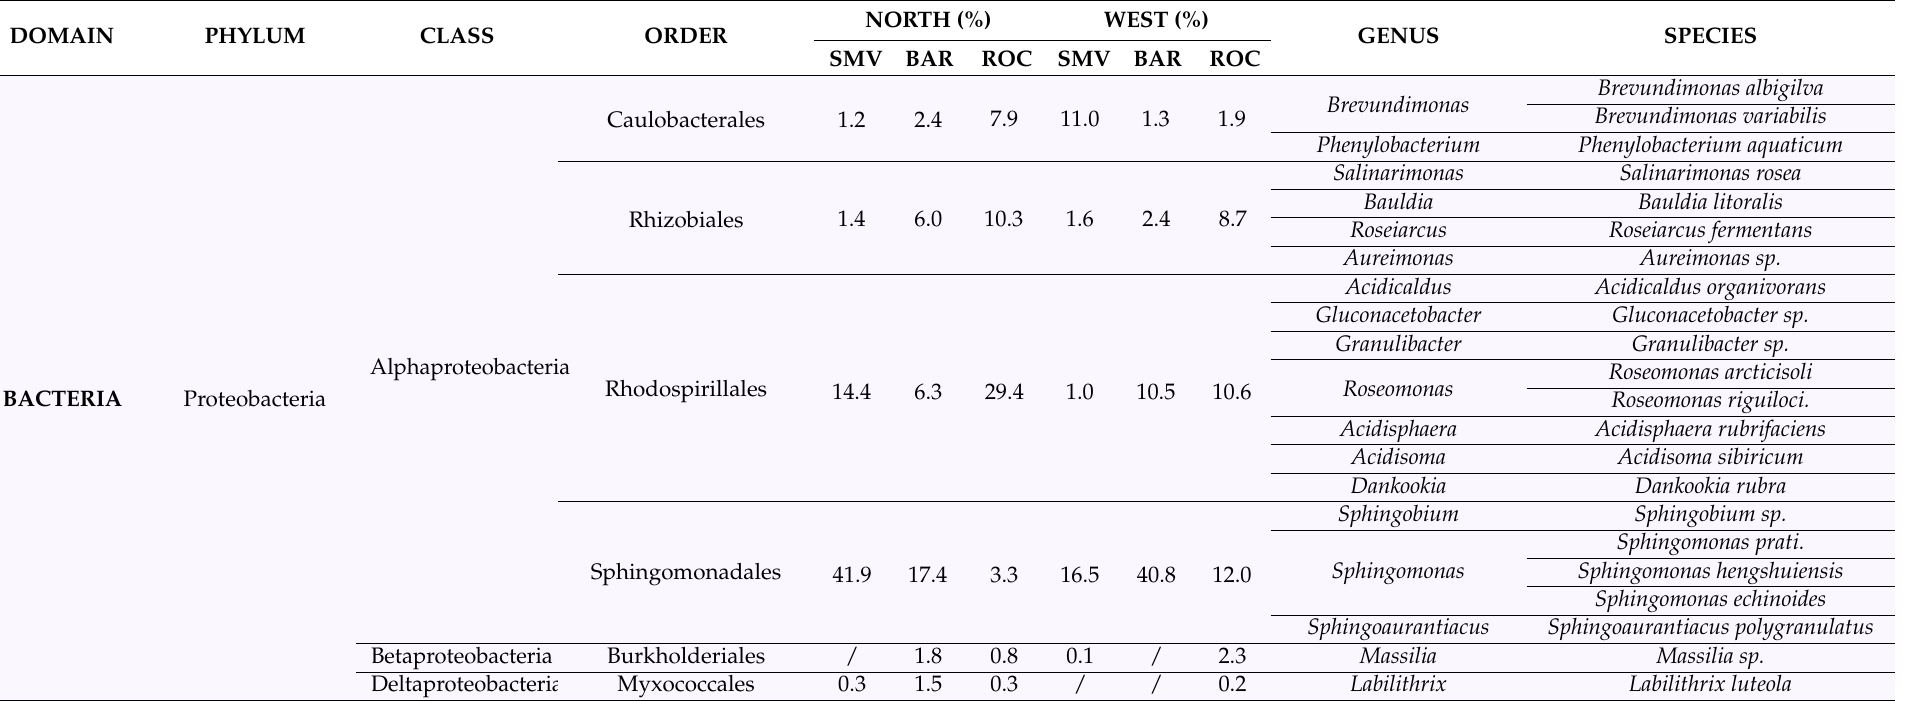
Table 2. Species composition and taxonomic classification of the main organism conforming the cultural heritage microbiome identified by NGS. Pink background corresponds to Bacteria phylum, while the brown background corresponds to Fungi